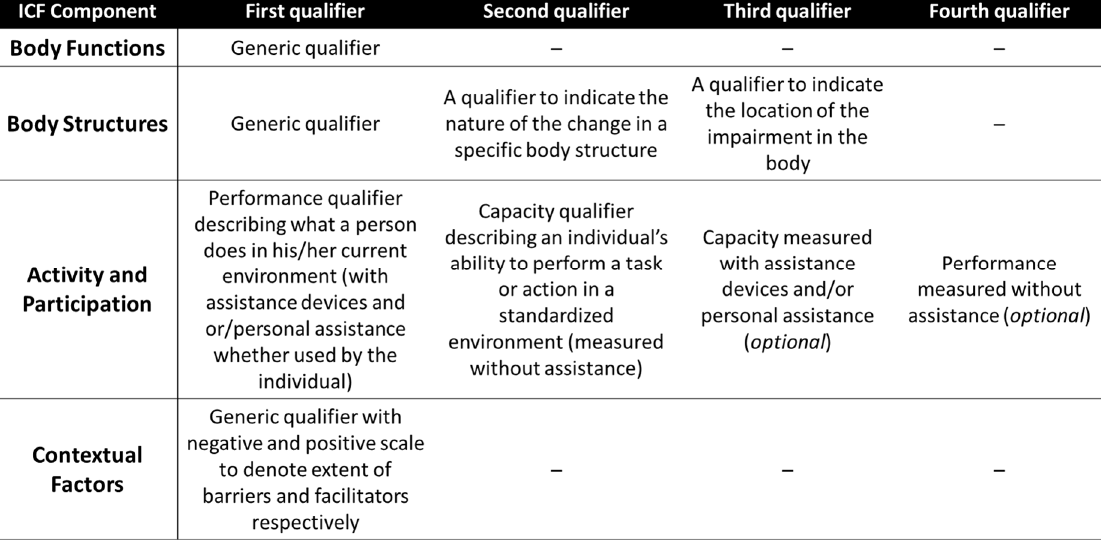
Figure 2. A description of all the possible qualifiers applicable for each ICF component and their meanings (according to References [39,44]).